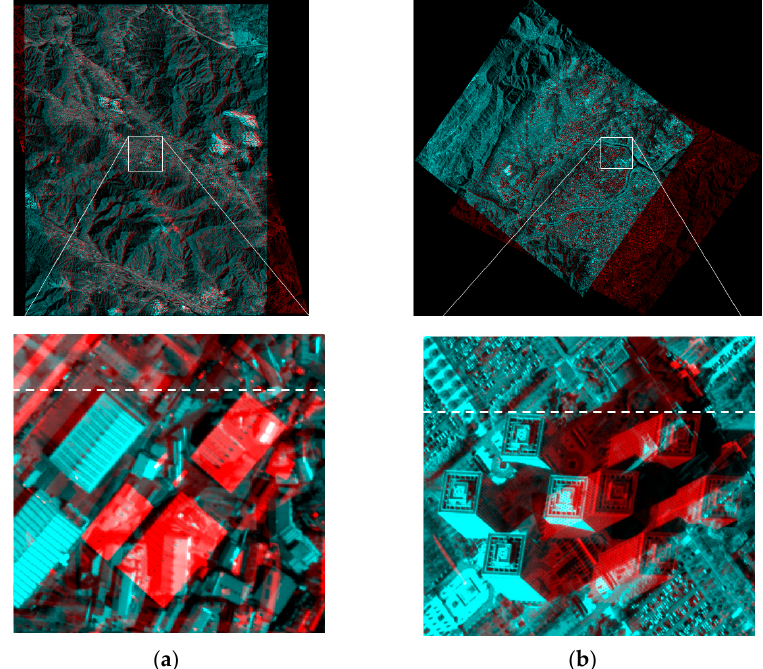
Figure 24. Final anaglyph images showing sub-pixel y-parallax ( a ) along-track Kompsat-3 and ( b )